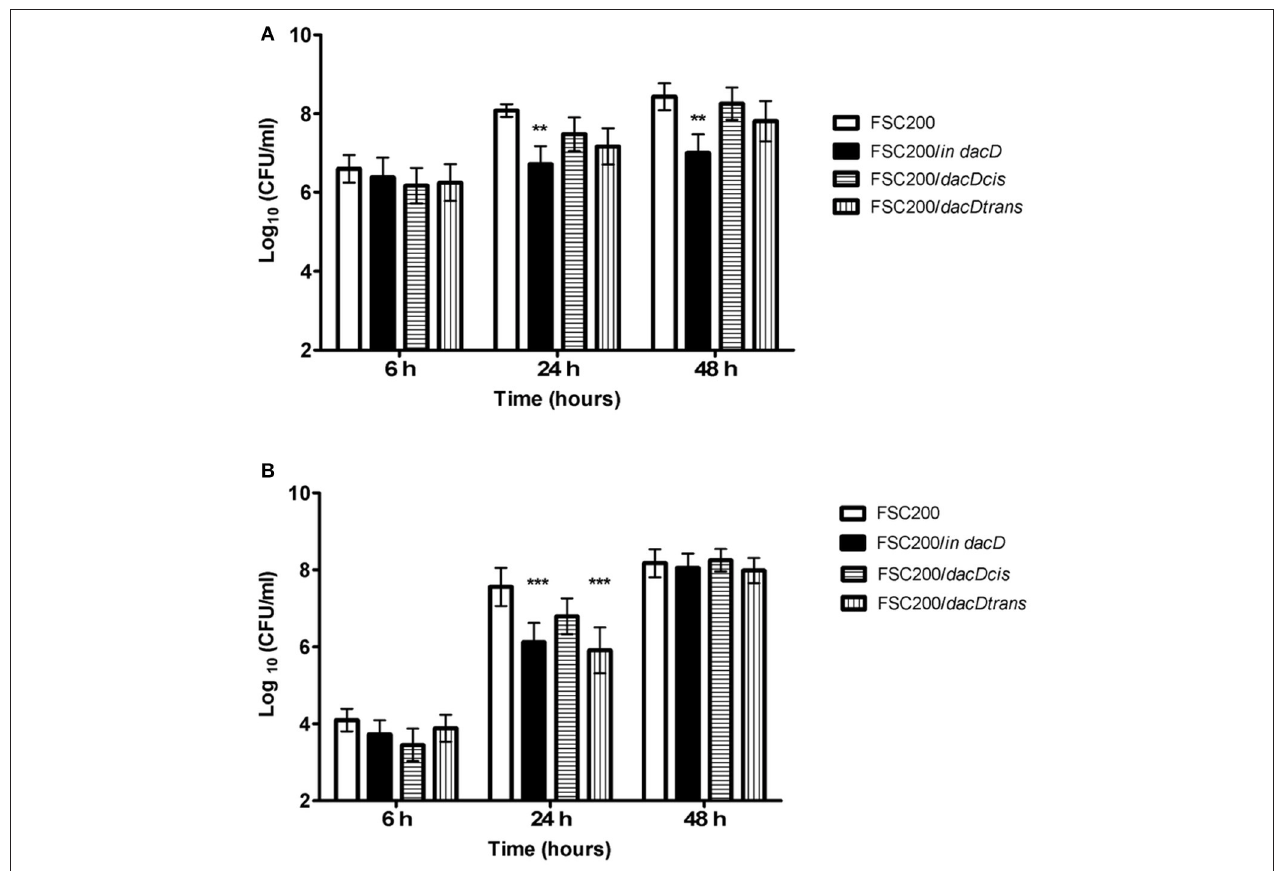
FIGURE 1 | Intracellular growth of the FSC200 /in dacD mutant strain is affected . (A) Replication inside bone-marrow derived macrophages. FSC200/ in dacD mutant strain shows significantly reduced proliferation inside BMMs 24 and 48h post infection. (B) Replication inside A549 cell line. The significant defect in replication in A549 cell line is visible only at time interval 24h post infection. At 48h post infection the replication rate of all strains is the same. ** P < 0.01, *** P <